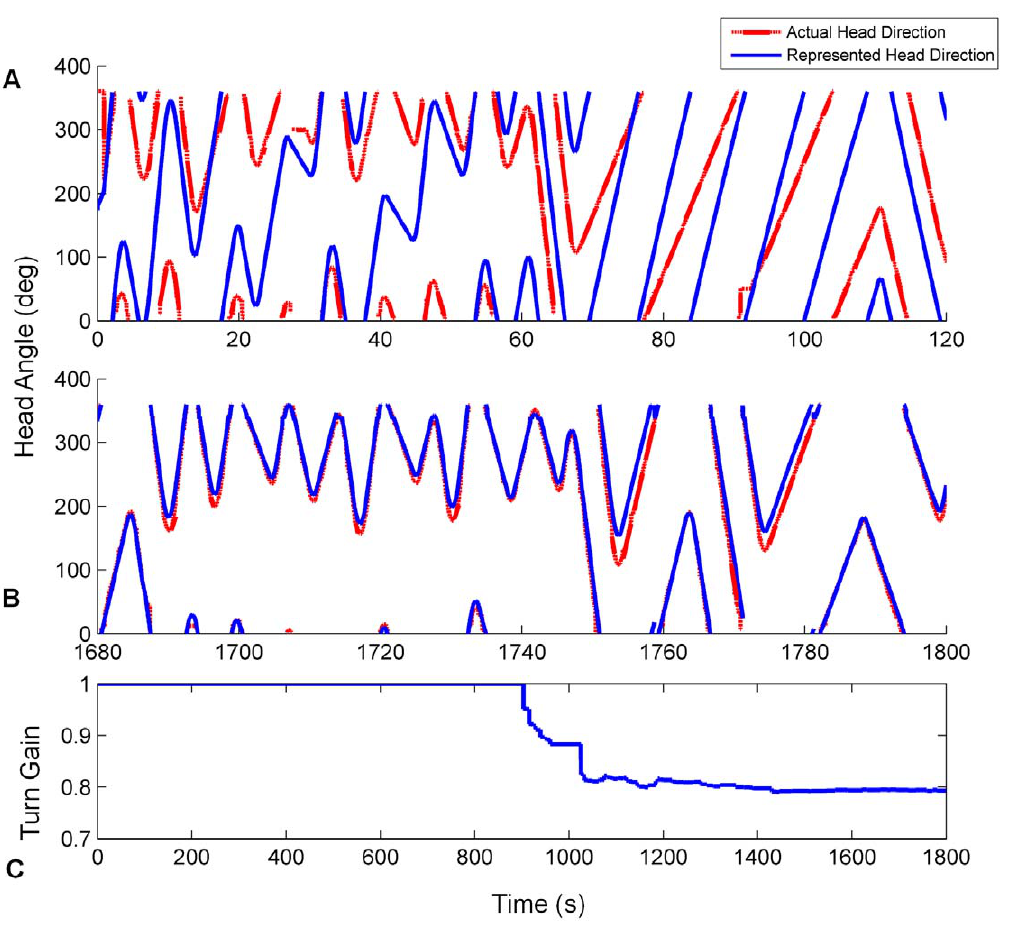
Figure 8. Head direction tracking improves as drift and turn gain are calibrated on the mobile robot. Actual and represented head directions are tracked for the first and final 120 seconds of training (respectively graphs (A) and (B)). X axis – time, Y axis – head orientation, dashed red – actual head position, solid blue – head position as represented in the HDAAN. (A) At the commencement of training, represented head direction drifts continuously upwards resulting in poor tracking of actual head direction. (B) At the completion of training, the represented head direction tracks actual head direction almost perfectly after the elimination of drift and equalization of turn rates (stability condition 1) and turn gain calibration (stability condition 2). (C) Turn gain is initialized to 1.0 prior to training and after 15 mins (900 secs) turn gain calibration commences. In the final 5 minutes of training the gain is stabilized at its final value.